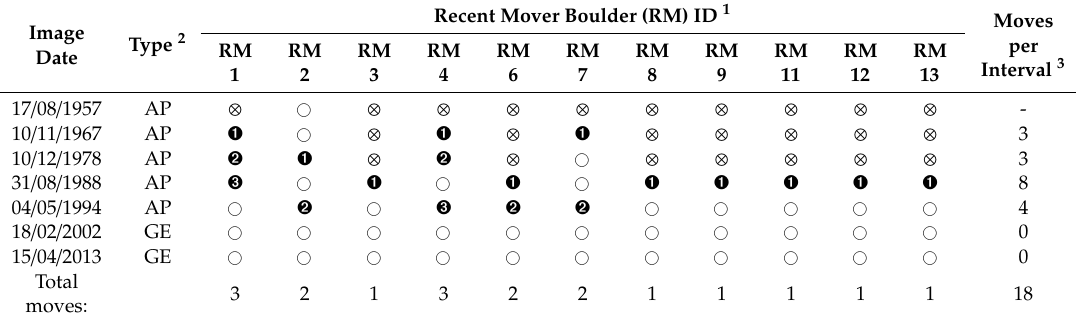
Table 2. Frequency of recent boulder movements